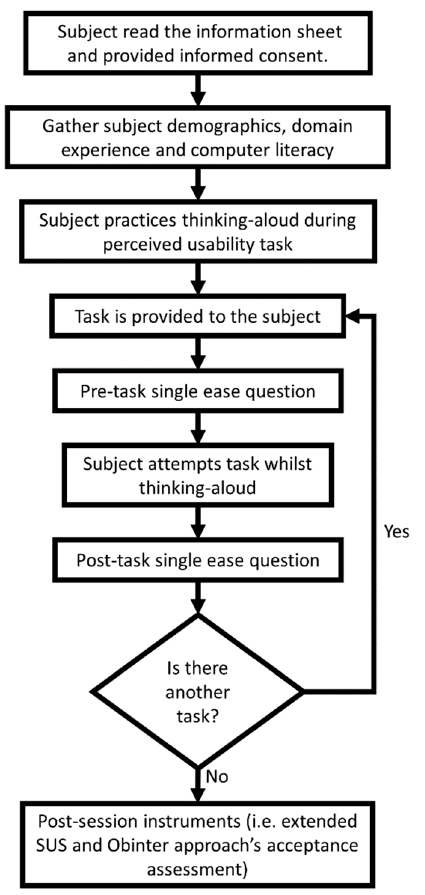
Figure 10. Defined Usability testing protocol diagram. This figure has been adapted from [44].